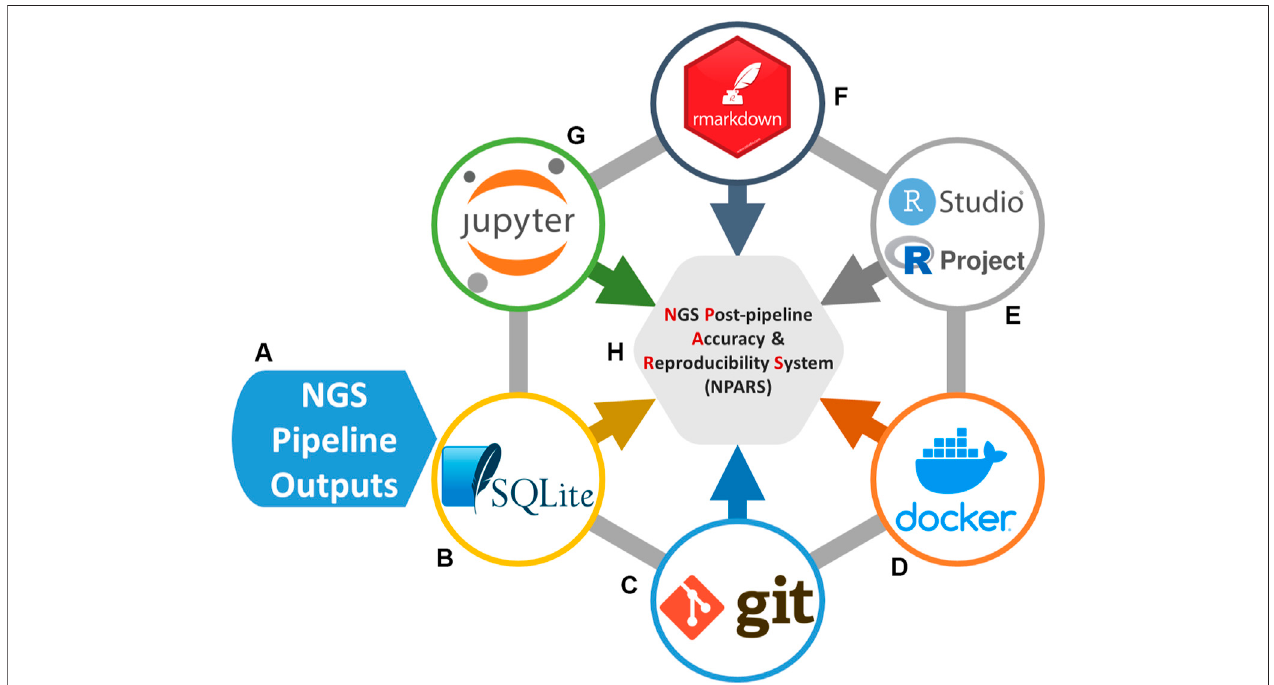
FIGURE 1 | Software technologies used for the NGS Post-pipeline Accuracy and Reproducibility System (NPARS) infrastructure creation. The six core technologiesusedareshown. (A) StudyresultsfromagenomicspipelineorrepositoryareextractedandpreparedforinsertionintoaSQLitedatabase. (B) SQLitestores all genomic study outputs along with salient study metadata. (C) Git provides version control of the Docker fi les (Docker image speci fi cation, i.e., analysis environment) and analysis source code. (D) Docker wraps the developmentenvironmental information into a container, simplifying software con fi guration management and, the initialization of a reproducible analysis environment. (E) RStudio, provides an integrated development environment for the R programming language and R Projects that areutilized,whichprovideanef fi cientwaytoorganizesoftwaredevelopmentactivities. (F) RMarkdowngeneratesself-documentinganalyticalreportsintoHTML fi les. (G) Jupyter Notebooks, are utilized as a development and visualization environment for Python-based projects and reports.